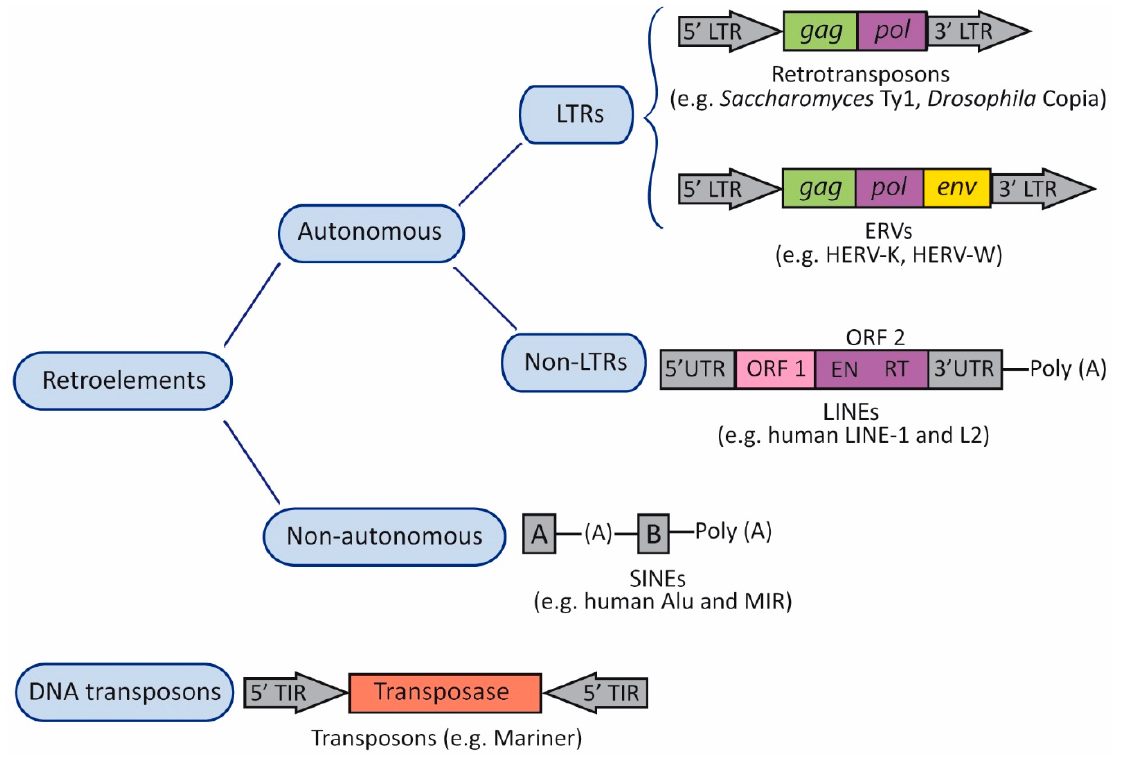
Figure 1. Transposable Elements (TEs). TEs can be organized into two major categories: retrotransposons (retroelements or class I elements) and DNA transposons (class II elements). Both types of TEs can be either autonomous or non-autonomous. Autonomous TEs encode reverse transcriptase (RT) and other proteins required for replication and transposition, whereas non-autonomous elements do not encode these proteins and need other TEs for their mobilization. Retrotransposons can be divided into two groups, according to the presence or absence of long terminal repeats (LTRs) flanking internal coding regions. The canonical autonomous LTR retrotransposons contain a small number of open reading frames (ORFs). Most elements contain an ORF including gag and pol domains, and endogenous retroviruses (ERVs) contain an ORF for env . Gag encodes a structural polyprotein, and pol encodes enzymatic activities: protease, RT, integrase, and ribonuclease H. ERVs contain a primer-binding site (PBS) located between the 5 ′ LTR and gag , and a polypurine trait (PPT) located between env and the 3 ′ LTR. The PBS binds the cellular tRNA priming the synthesis of the (–)strand DNA, and the PPT acts as a primer for the (+)strand DNA. Non-LTR retrotransposons include long interspersed nuclear elements (LINEs), and short interspersed nuclear elements (SINEs). The canonical LINE-1 element has two ORFs (ORF1 and ORF2) flanked by 5 ′ and 3 ′ UTRs; the 5 ′ UTR includes an RNA polymerase II promoter, and the element ends with a poly (A) tail. The canonical Alu element consists of two monomers (A and B) separated by an (A)-rich linker region, and ends with a poly (A) tail. A and B boxes are transcriptional promoters for RNA polymerase III. In DNA transposons, the transposase is flanked by terminal inverted repeats (TIRs).